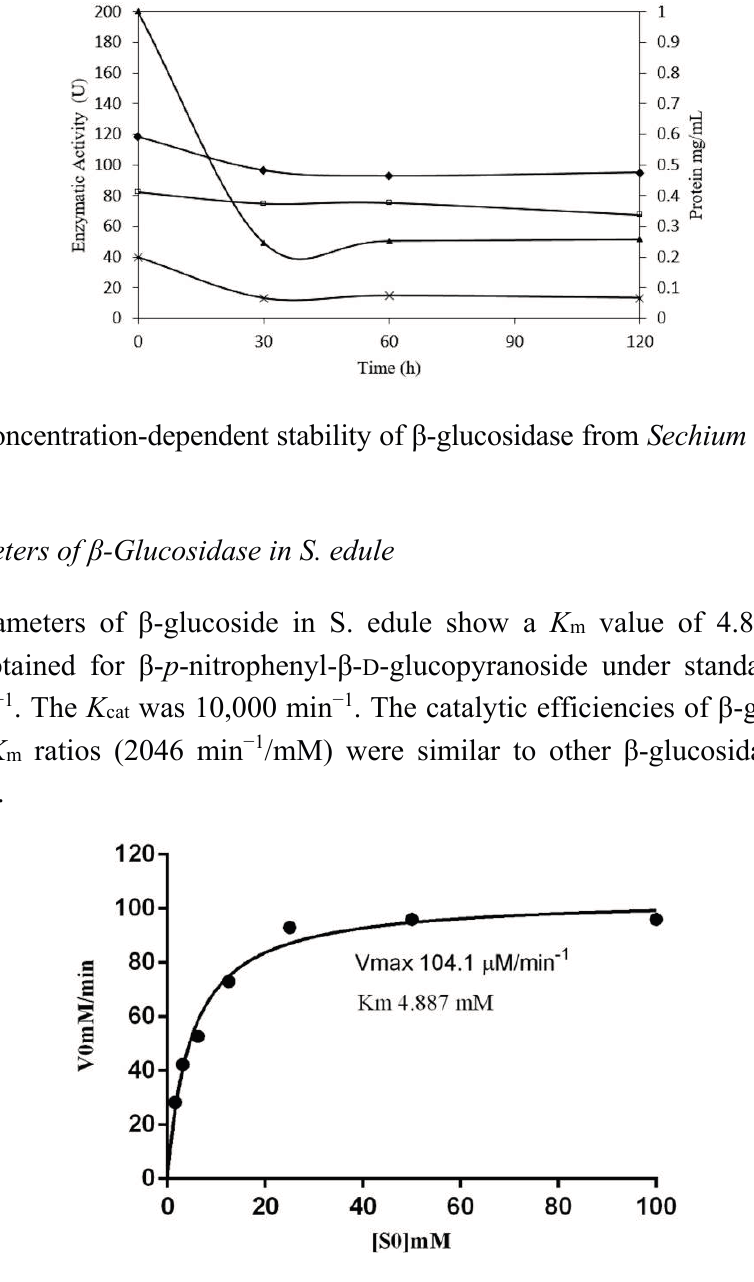
Figure 13. Michaelis-Menten enzyme kinetics. K m and V max for β -glucosidase in S. edule with p -nitrophenyl- β - D -glucopyranoside as